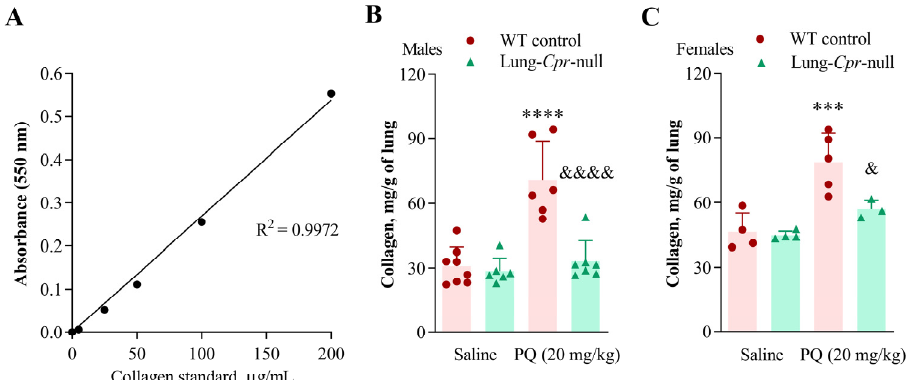
Figure 5. PQ-induced increase in collagen content in mouse lung homogenate. Three- to four-month-old lung- Cpr -null mice and WT control littermates received a single intraperitoneal injection of saline or PQ (20 mg/kg). The lungs were harvested for analysis on day 15 after the injections. ( A ) Collagen standard curve for the Sirius red colorimetric plate assay. Signal intensity was linear over the assay range. Each point is the mean of duplicate assays. ( B , C ) Sirius-red collagen quantification was performed in lung homogenate for males ( B ) and females ( C ) as outlined in Material and Methods . Results represent means ± S.D. ( n = 3–8 per group). & , p < 0.05, &&&& , p < 0.0001, by mouse genotype; ***, p < 0.001, ****, p < 0.0001, by exposure (one-way ANOVA followed by Bonferroni’s test for multiple comparisons).